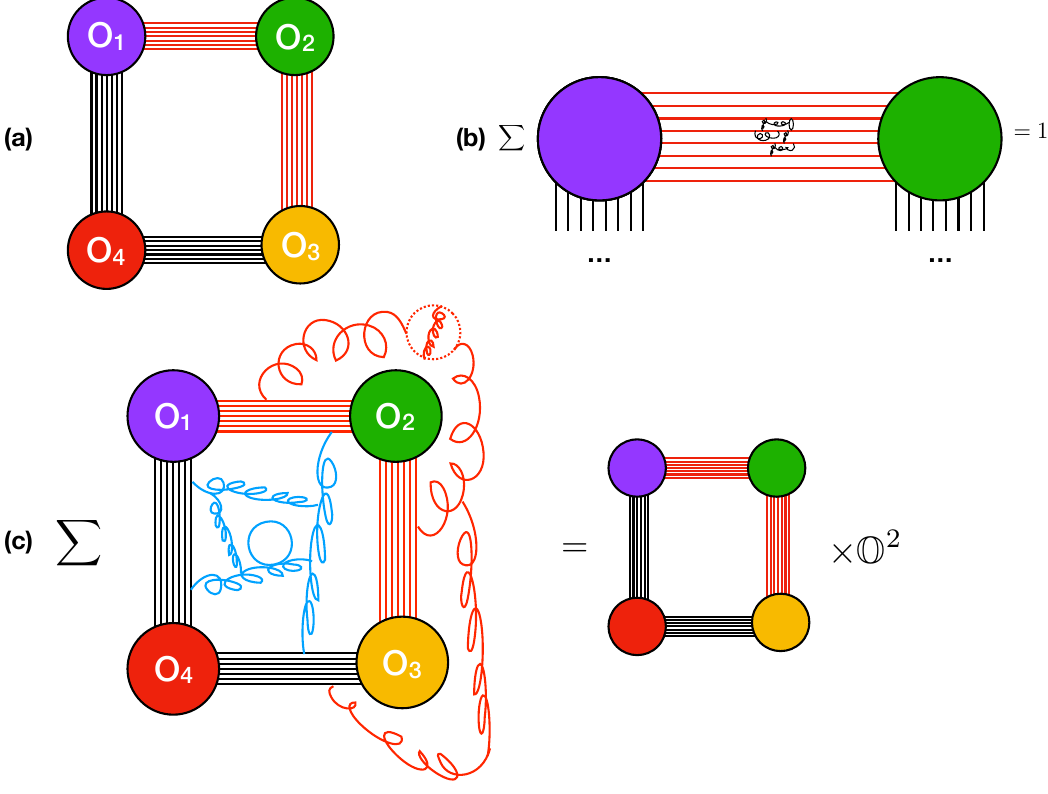
Figure 1 . Large cyclic operators at genus zero. (a) The tree-level result is given by a single Feynman graph of rectangular form. For large operators, this rectangle creates a big frame. (b) The frame, when big, does not receive loop corrections because of supersymmetry. Indeed these loop corrections are indistinguishable from those arising in the two-point function of BPS operators, a protected quantity. (c) The inside and the outside of the frame, on the other hand, are loop corrected. The sum of all quantum corrections to the inside (or outside) de(cid:12)ne a function O of the ’t Hooft coupling and of the four-point cross